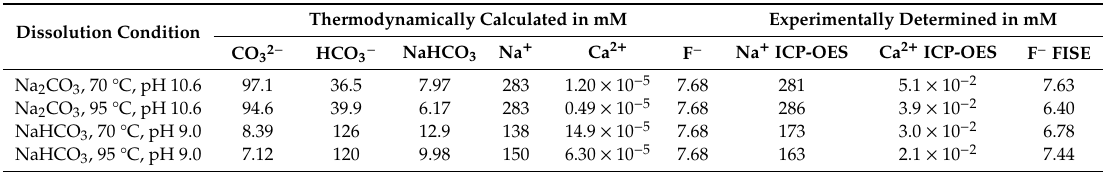
Table 1. Thermodynamically calculated and experimentally determined concentrations (mM) of aqueous species with 300 mg / L CaF 2 and 150 mM of dissolution agent.